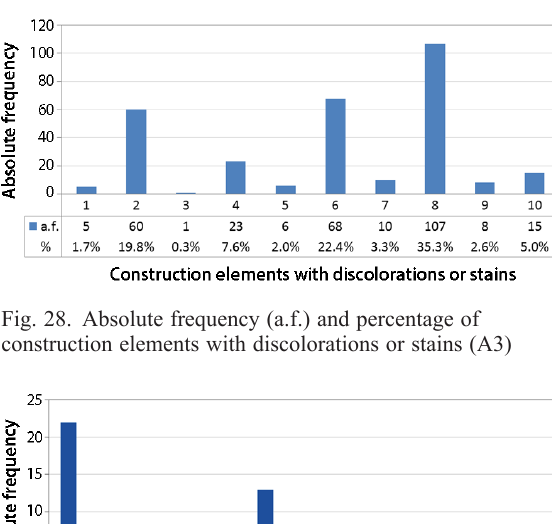
Fig. 27. Absolute frequency (a.f.) and percentage of previous defects for stains (A3) in the case studies